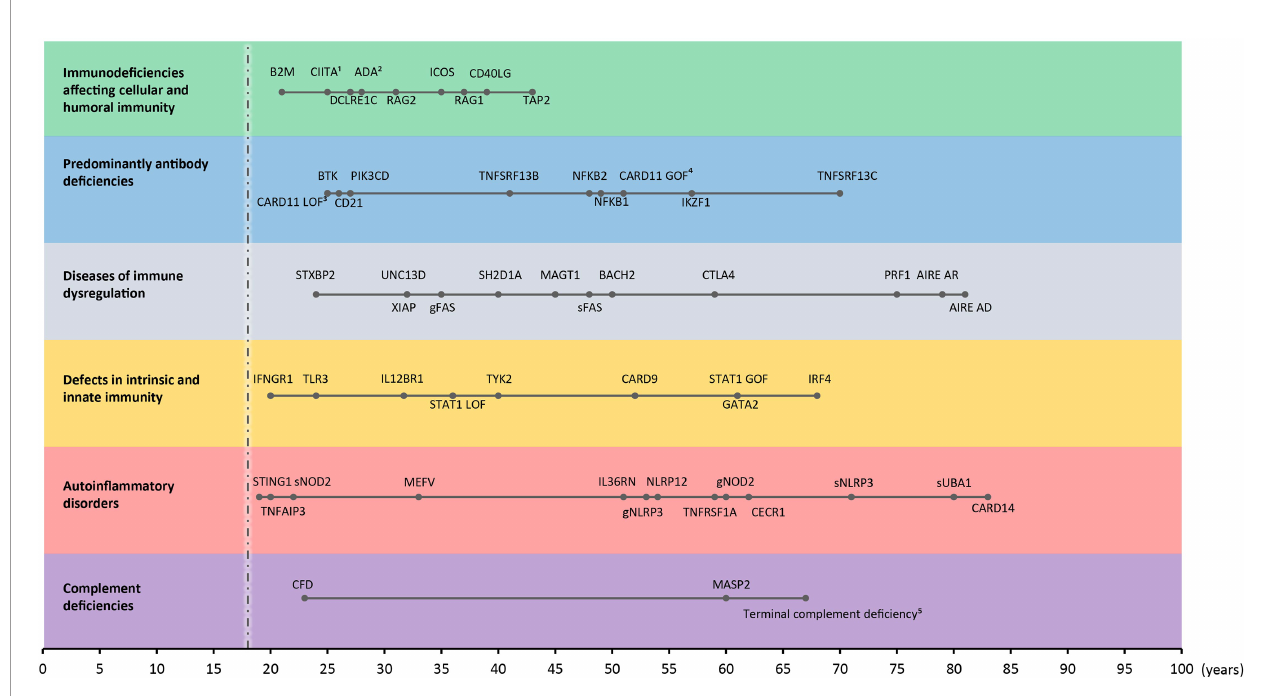
FIGURE 3 | Time of onset in adult IEI. Adult-onset IEI genes with oldest age-of-onset patient reported for every gene (from all reviewed manuscripts) in each category. s: somatic. g: germline. 1 onset between 20-30 years, 2 immunological abnormalities, 3 onset in mid-twenties, 4 asymptomatic, 51 years old, 5 genetic defect in C5/6/7/8 or 9, mean age of oldest presentations. Dashed line indicates threshold for adult-onset (18-years-old).